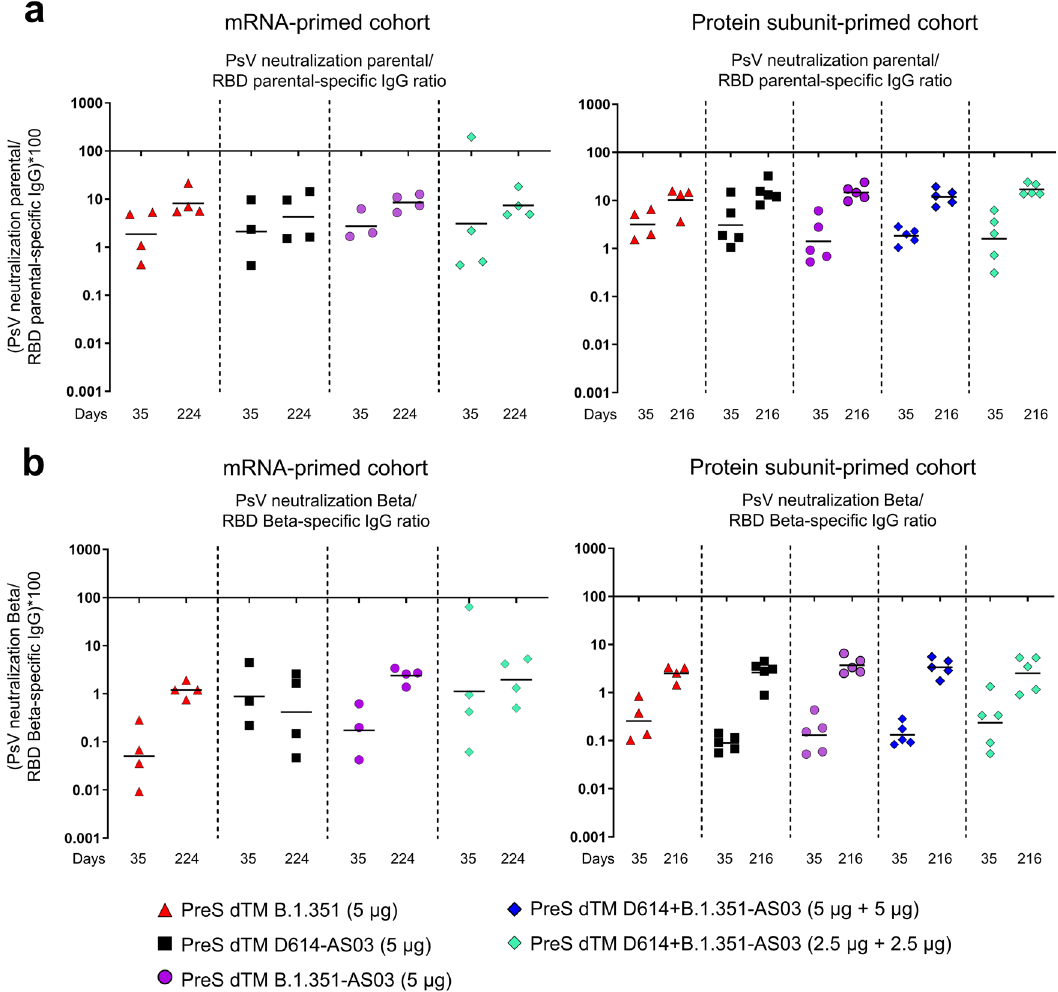
Fig. 3 Booster immunization elicits an increase in functional antibody response in mRNA- and subunit-primed macaques. Pseudovirus NAb/RBD- binding IgG ratio for parental D614G ( a ) and for Beta ( b ), post prime (D35) and 2 weeks post-boost (D224 or D216) for mRNA-primed cohort ( n = 4/group) and subunit-primed cohort ( n = 4 – 5/group). Individual animals are shown; bars indicate